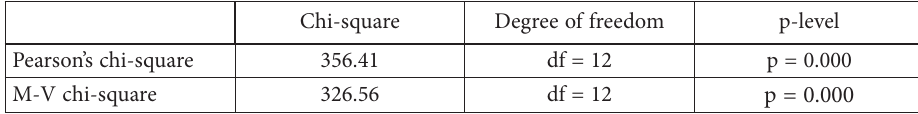
Table 9. χ 2 test for motivational factor good working team from the point of view of education Chi-square